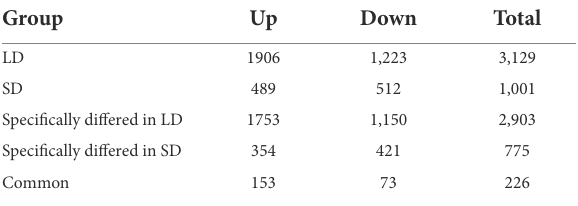
TABLE 1 DEGs between transgenic GmFT3a soybean and control in LD and SD